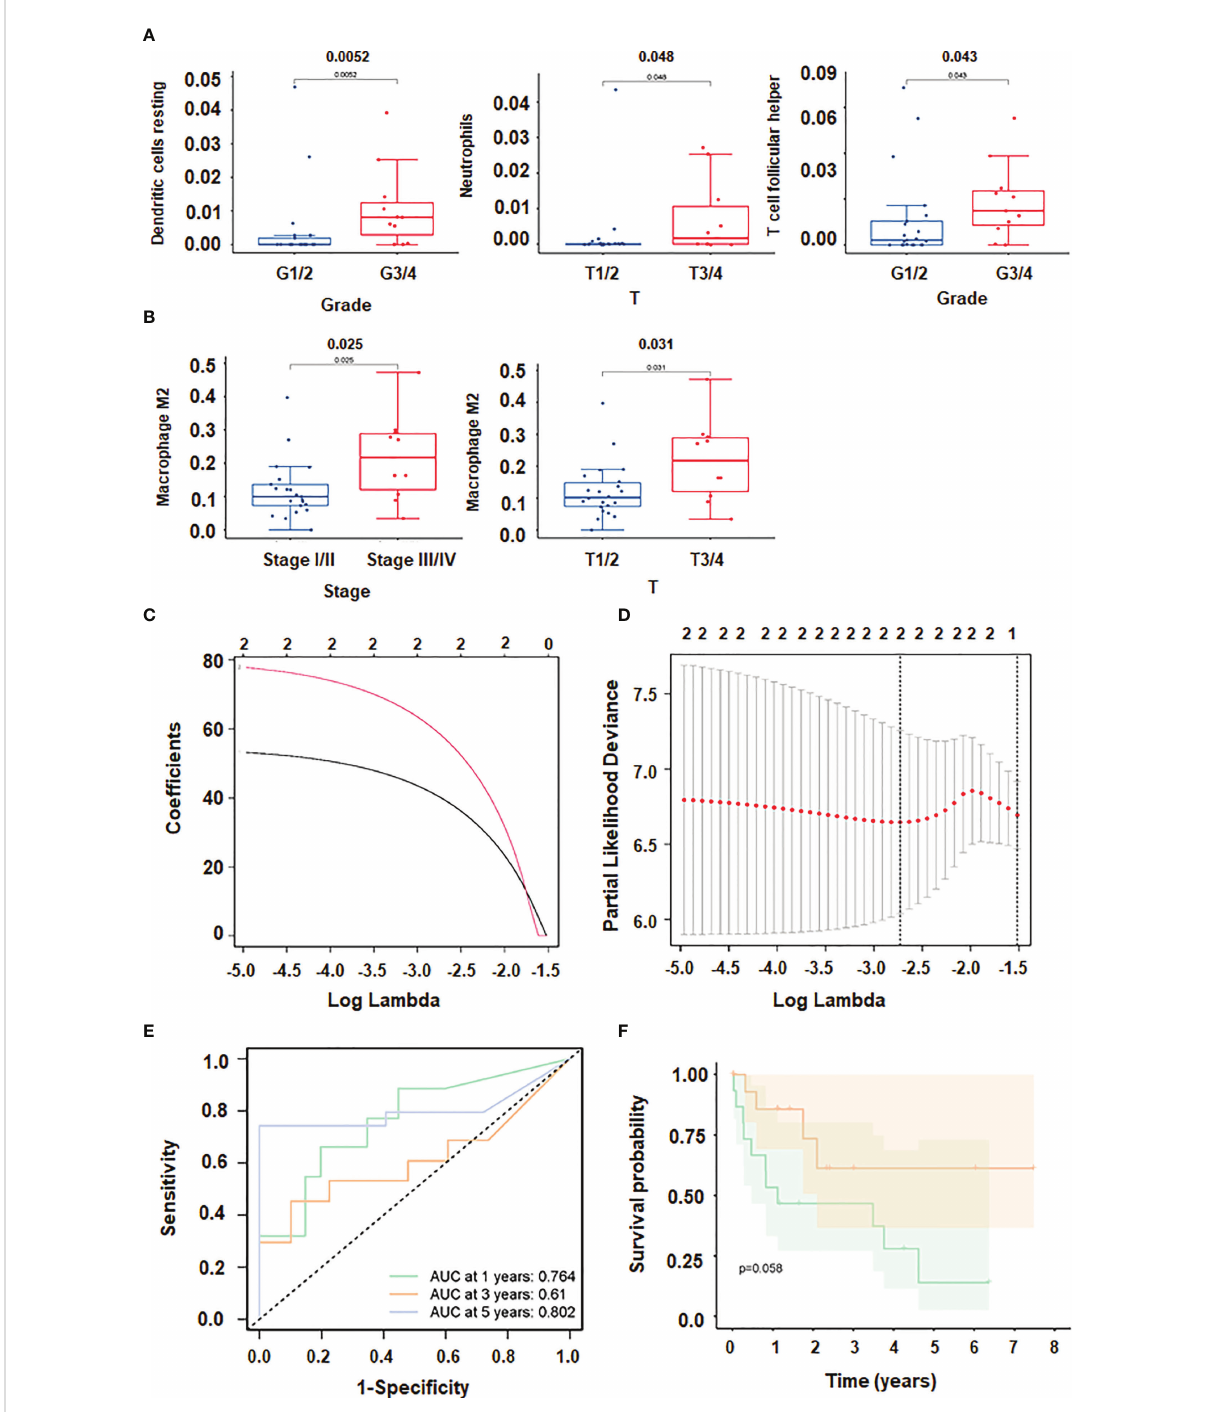
FIGURE 6 Immune cell in fi ltration in HCC. (A, B) Correlation between immune cells and clinical shape. (C, D) : different characteristics of immune cells and their corresponding coef fi cients; (E) ROC curve plotted under the prediction model). (F) KM curve of this prediction